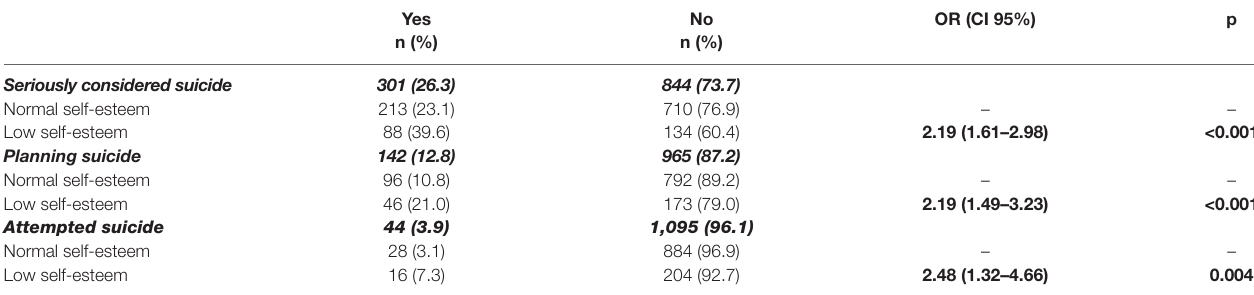
Significance levels were at the 0.05 level